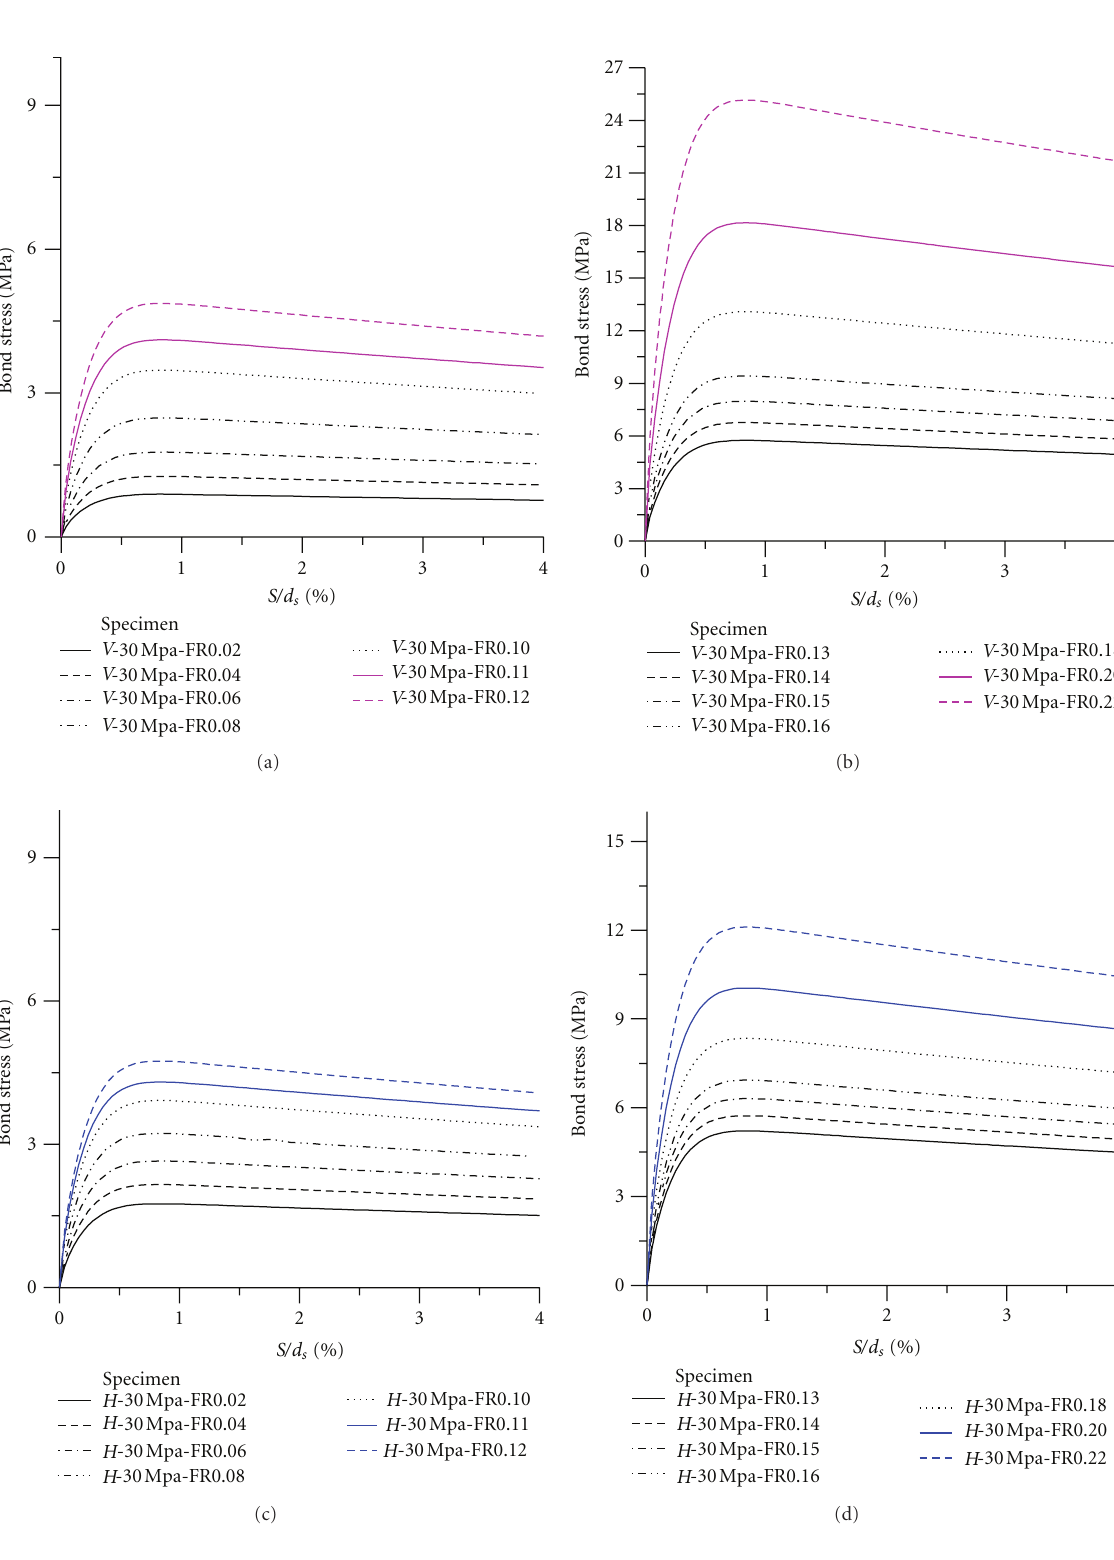
Figure 6: E ff ects of bond factors ( f (cid:3) c = 30 MPa, 100 / A c = 0 .